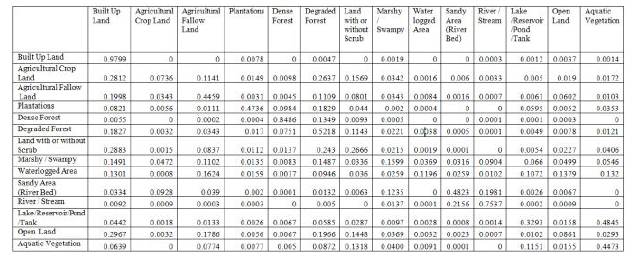
Table 3. Transition probability matrix of 1987 and 1997 LULC